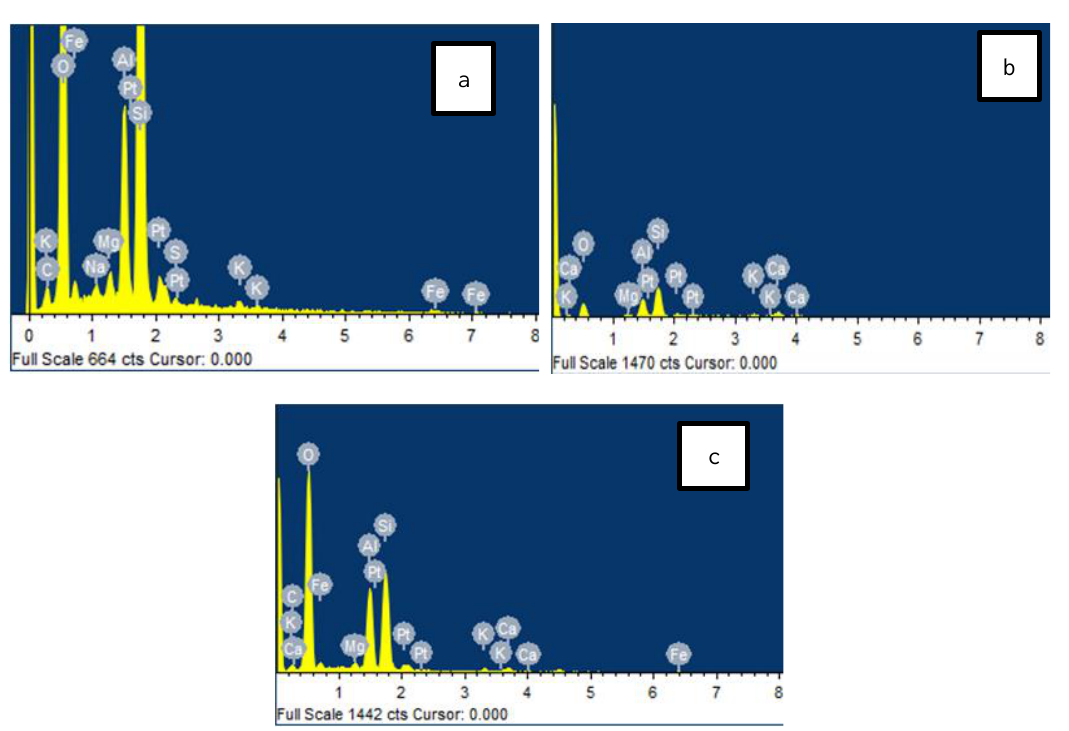
Figure 10. 90 day curing period of the EDX spectrum for ( a ) untreated clay, ( b ) CLF 5C, and ( c ) CFAF90 5C. Table 5. EDX Analysis for untreated and treated clay wetting/drying sample after a curing period of 90 days.